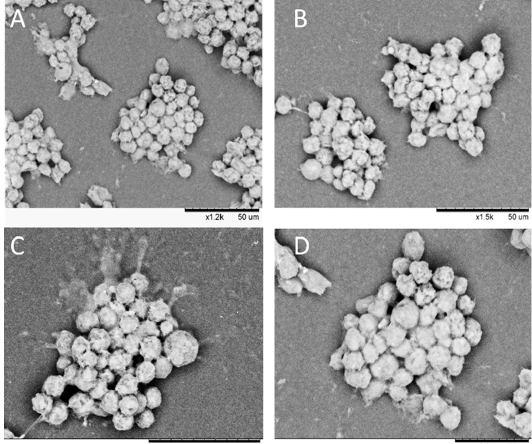
Figure 7. SEM images of a sample of HaCaT cell clusteroids after being removed from the medium, deposited on a glass substrate and freeze dried before imaging. ( A )-( D ) Images correspond to different resolutions. Note that the size of the clusters of cells is slightly lower than the original cell clusteroids due to shrinkage.